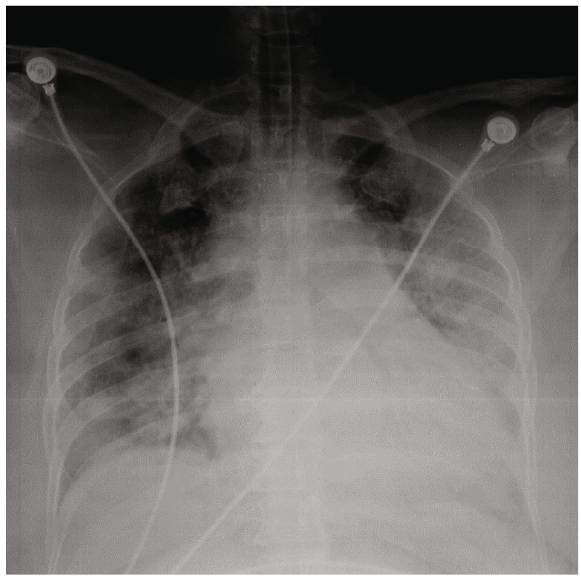
Figure 4: Chest X-ray of case 2 after 3 days in ICU. Endotracheal tube in situ. There is worsening of the shadowing of both lungs.